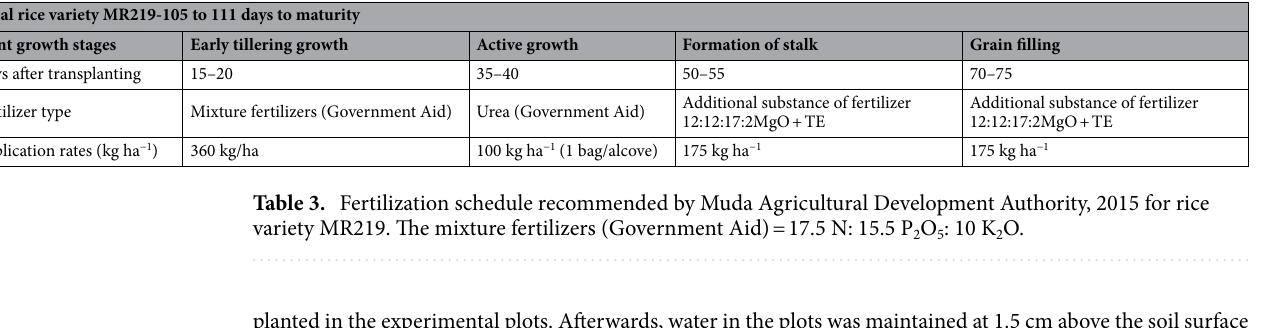
Additional substance of fertilizer 12:12:17:2MgO + TE